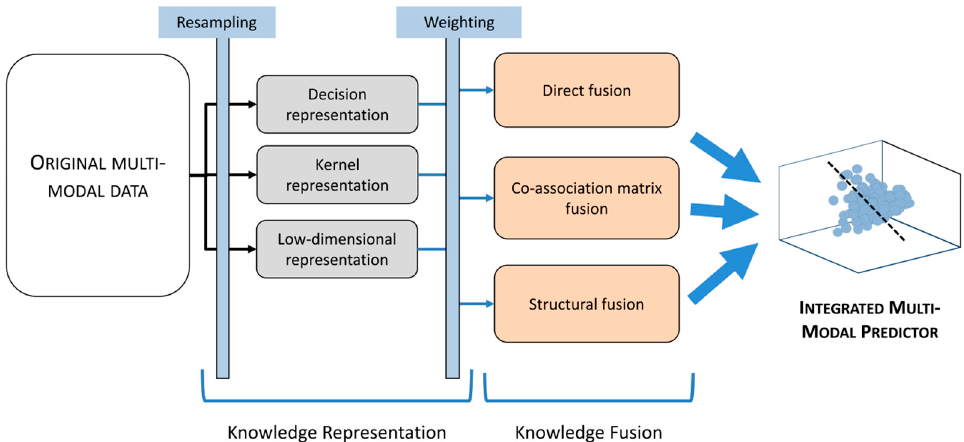
Figure 10. Modality-specific scale and dimension differences are eliminated through knowledge representation, which transforms each modality individually into a unified space. Resampling refers to the generation of multiple representations and weighting considers individual characteristics of the modalities. In order to achieve the best fused result from different modalities, complementary information from every channel should be used. Reprinted with permission from reference [81], 2018, Viswanath et al.